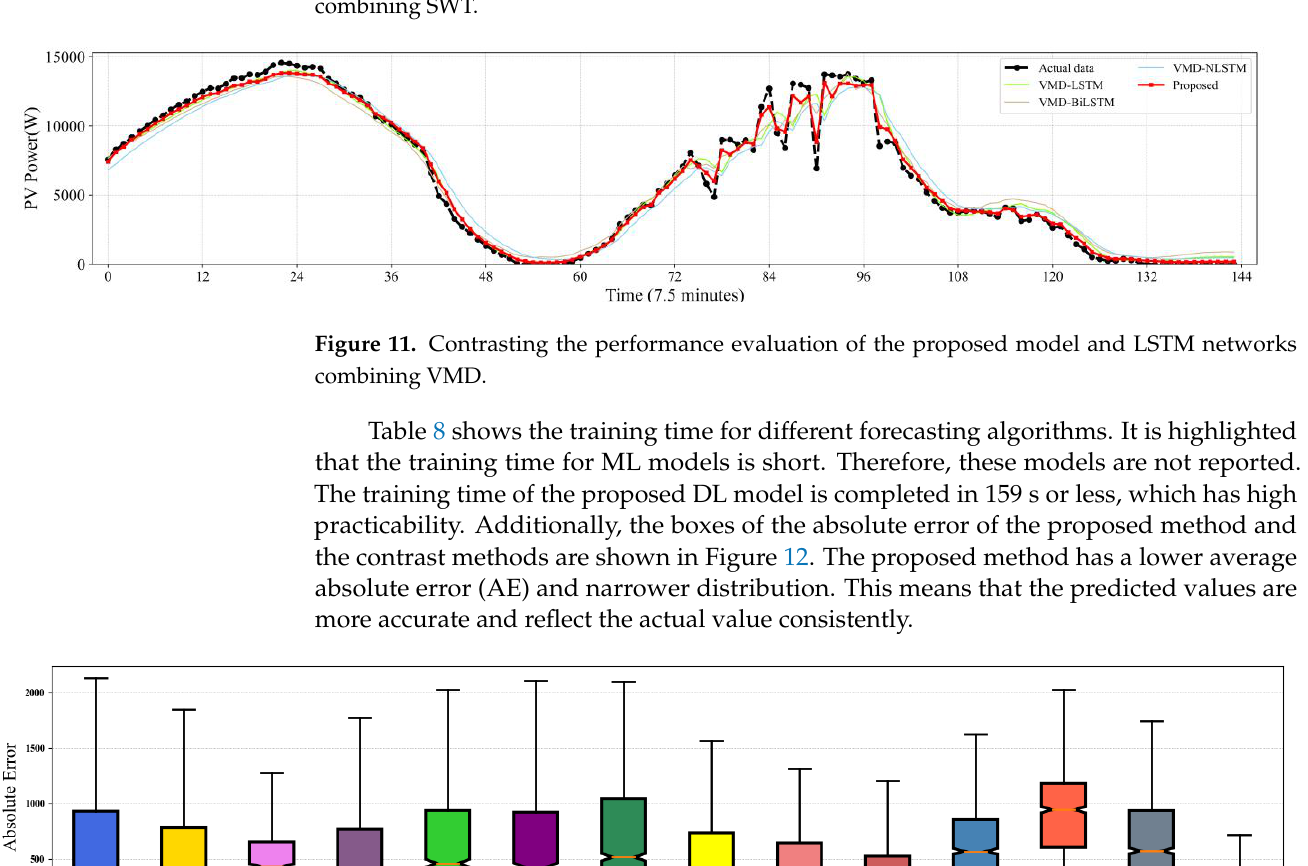
Figure 12. The absolute error of the proposed model and the compared methods.